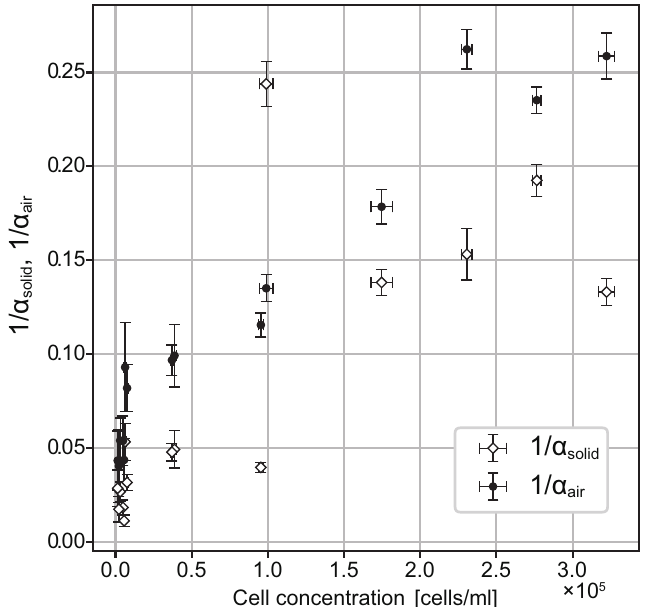
Figure 4. Accumulation coefficients calculated from experimental data. The error bars for the accumulation coefficients and cell concentration are due to the time average and dispersion of the 21 snapshots of the respective sample. The larger the coefficient, the larger the cell number ratio between the interface and the